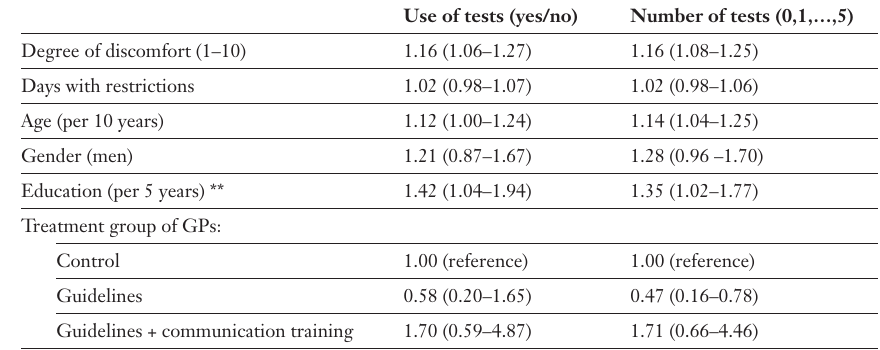
Predictors for diagnostic